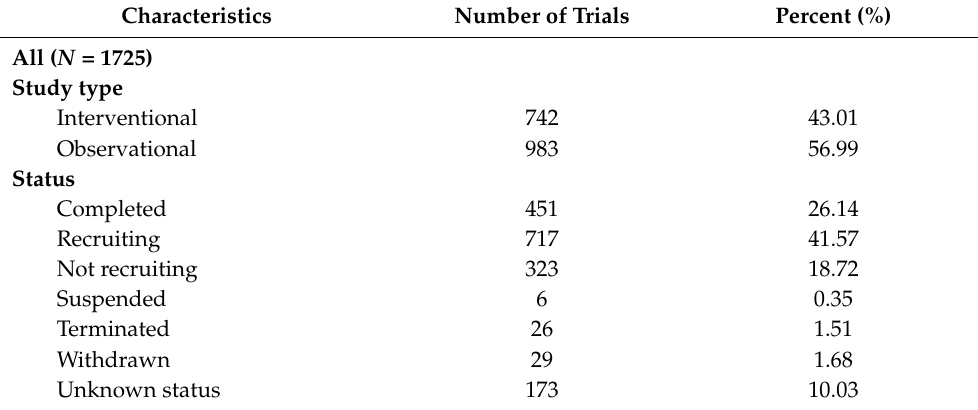
Table 2. Study design elements of AI-related trials registered in